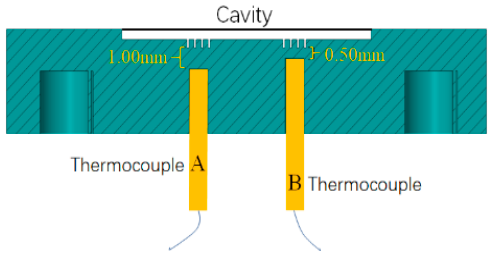
Figure 5. Schematic diagram of the thermocouple layout.